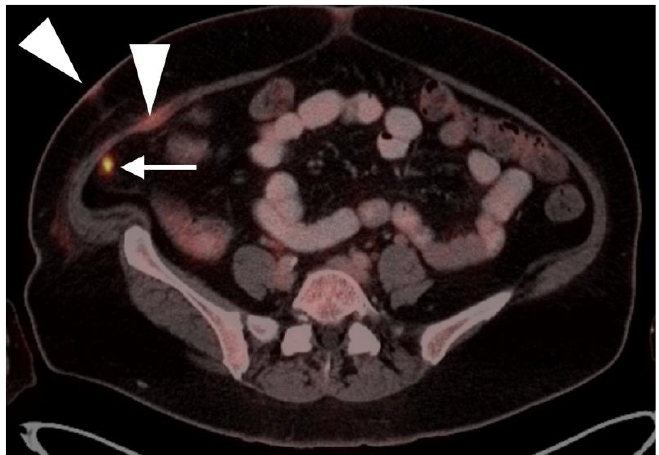
Figure 8. Seeding of the peritoneum with ovarian cancer with laparoscopic removal. Laparoscopic removal of ovarian cancer carries a higher risk of seeding the peritoneum with tumor, seen here on an axial FDG PET-CT image of the abdomen, with a small hypermetabolic tumor nodule (white arrowhead) near a laparoscopic port site (white arrowhead).